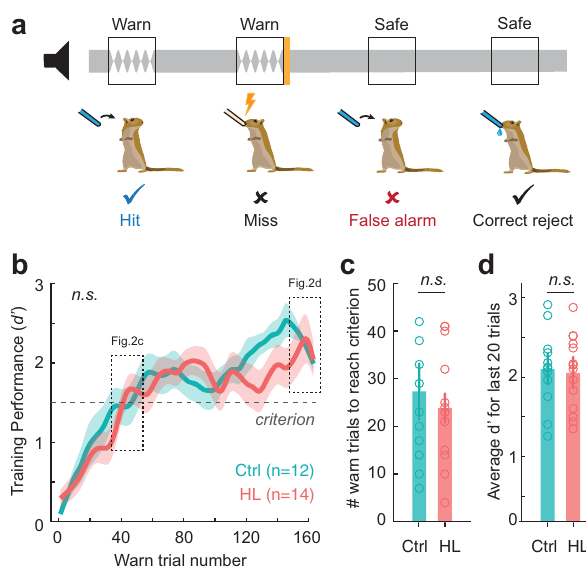
Fig. 2 Hearing loss (HL) during adolescence does not alter procedural training performance in adulthood. a Schematic of the amplitude modulation (AM) detection task. Animals were trained to drink from a water spout in the presence of continuous broadband noise (Safe trials; classi fi ed as a “ correct reject ” ) and to cease drinking when the noise transitioned to a modulated “ Warn ” signal (0 dB relative to 100% AM noise; 5 Hz rate; classi fi ed as a “ Hit ” ). Failure to withdraw from the spout during Warn trials (classi fi ed as a ” Miss ” ) resulted in a mild aversive shock. Withdrawing from the spout during Safe trials is classi fi ed as a “ False Alarm ” . Behavioral performance is quanti fi ed by utilizing the signal detection metric, d ′ . b Procedural training sessions (3-4 separate sessions) were combined to compute behavioral performance ( d ′ ) as a function of warn trial number using a 5-trial sliding window. Dotted line boxes correspond to data shown in c , d . Data are depicted as the mean ± SEM. Adolescent HL did not alter d ′ as a function of warn trial number as compared to controls ( p = 0.61, two-way mixed-model ANOVA). c The number of warn trials to reach performance criterion ( d ′ ≥ 1.5; see horizontal line in b ) for control (Ctrl) and HL-reared animals are comparable ( p = 0.59, one-way ANOVA). d Adolescent HL had no effect on the average d ′ for the last 20 trials of procedural training ( p = 0.82, one- way